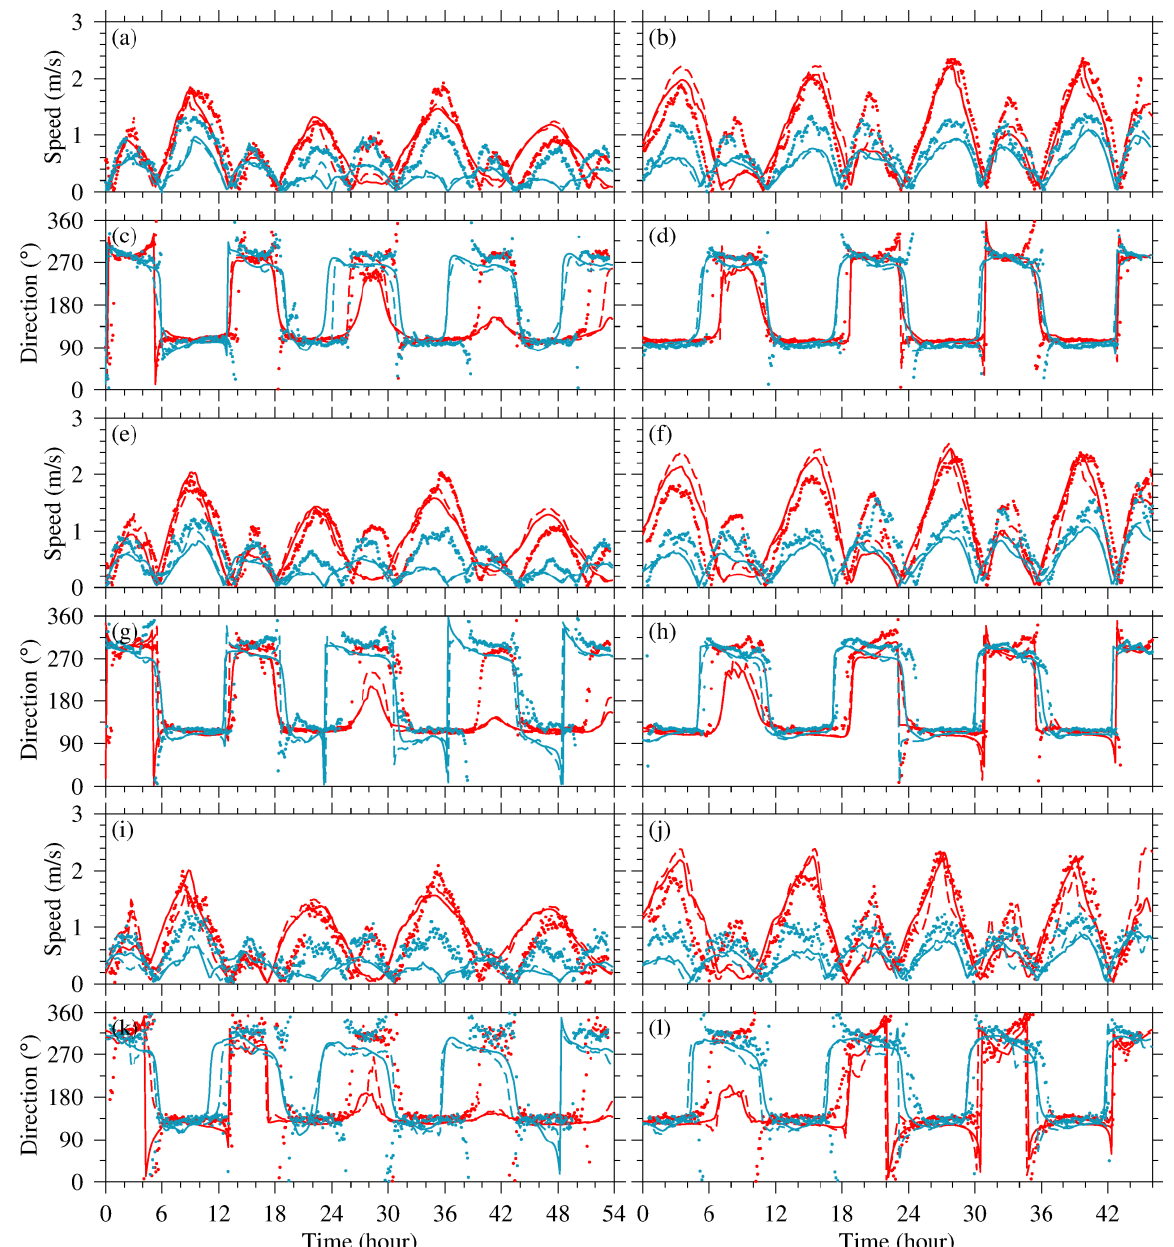
Figure 11. Time series of flow velocity and direction obtained from the observed data (dots), Exp. 0 (solid lines) and Exp. 3 (dashed lines) at sites A ( a – d ), B ( e – h ) and C ( i – l ) during neap tide (left panel) and the MTAN (right panel). Red indicates surface and blue indicates bottom.